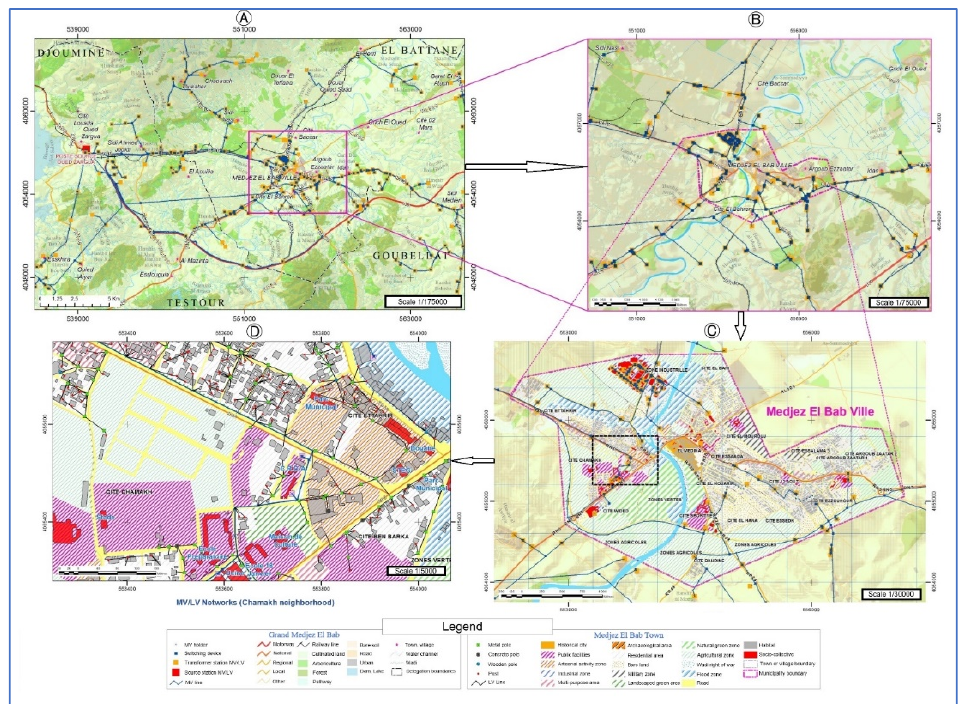
Figure 13. Presentation at different scales of MV/LV electrical networks.